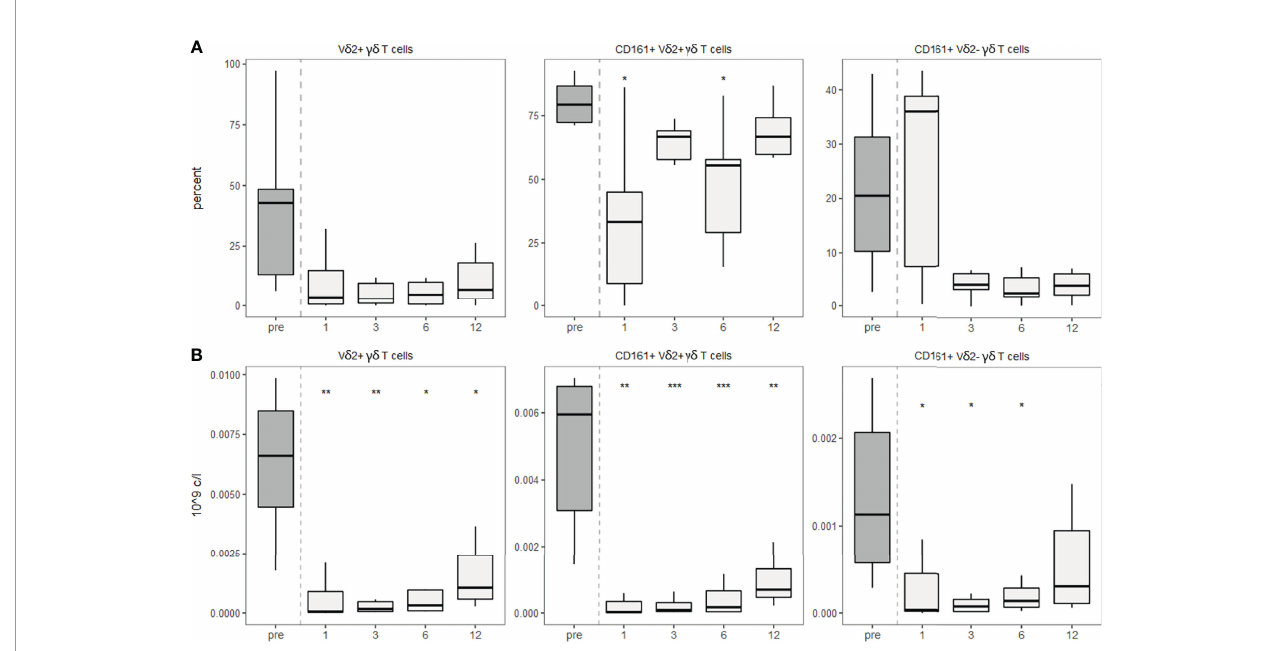
FIGURE 6 | gd T cells show decreased usage of V d 2 after aHSCT in MS. PBMCs were stained with fl uorophore-conjugated surface antibodies and analyzed by fl ow cytometry. (A) Percentage of V d 2 fraction of gd T cells (left), percentage of CD161+ cells within V d 2+ gd T cells (middle), percentage of CD161+ cells within V d 2- gd T cells (right). (B) Absolute numbers of V d 2+ gd T cells (right), absolute number of CD161+ V d 2+ gd T cells (middle), absolute number of CD161+ V d 2- gd T cells. Number of samples were pre = 7, M1 = 7, M3 = 7, M6 = 7, M12 = 7. As a global test, Kruskal-Wallis was used, and in case of signi fi cance followed by pairwise comparisons (pre vs 1, 3, 6 and 12 months) using Wilcoxon signed-rank